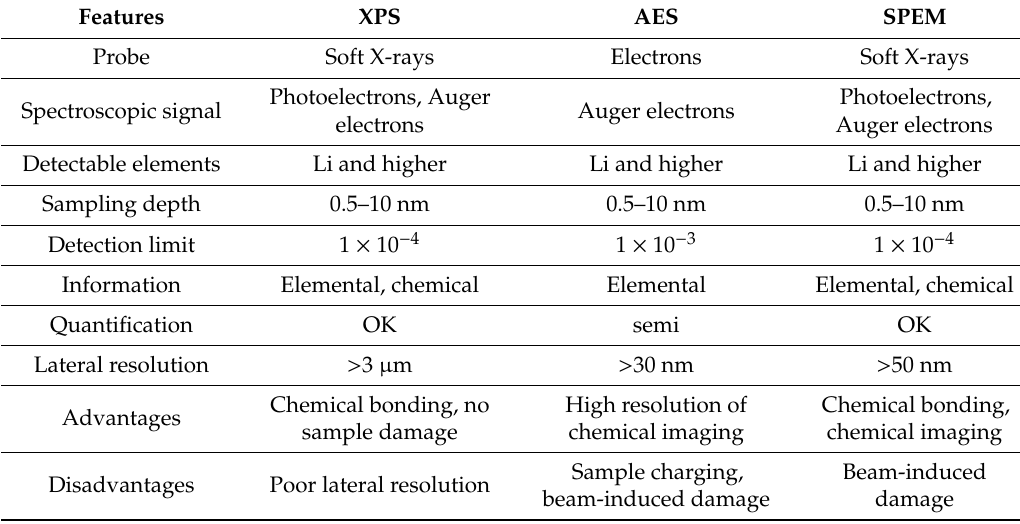
Table 1. Comparison of the main features of three ESCA